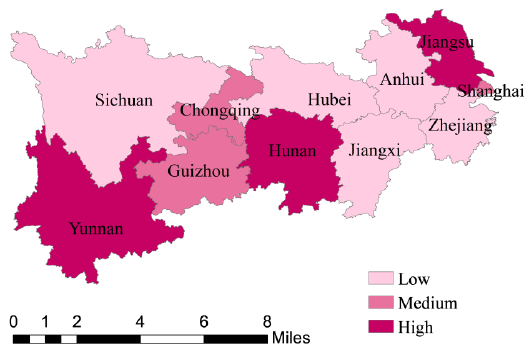
Figure 4. Same as Figure 3, but for the EC (technical efficiency) index.